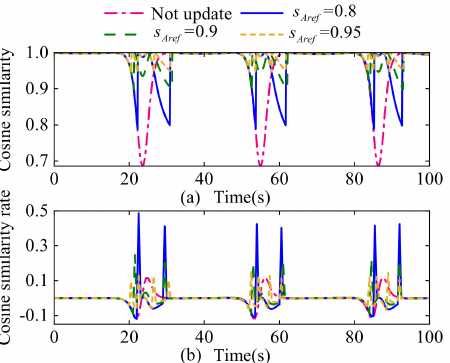
Figure 20. Cosine similarity of the state A matrix and its change rate under the sine speed input: ( a ) cosine similarity; ( b ) cosine similarity rate.